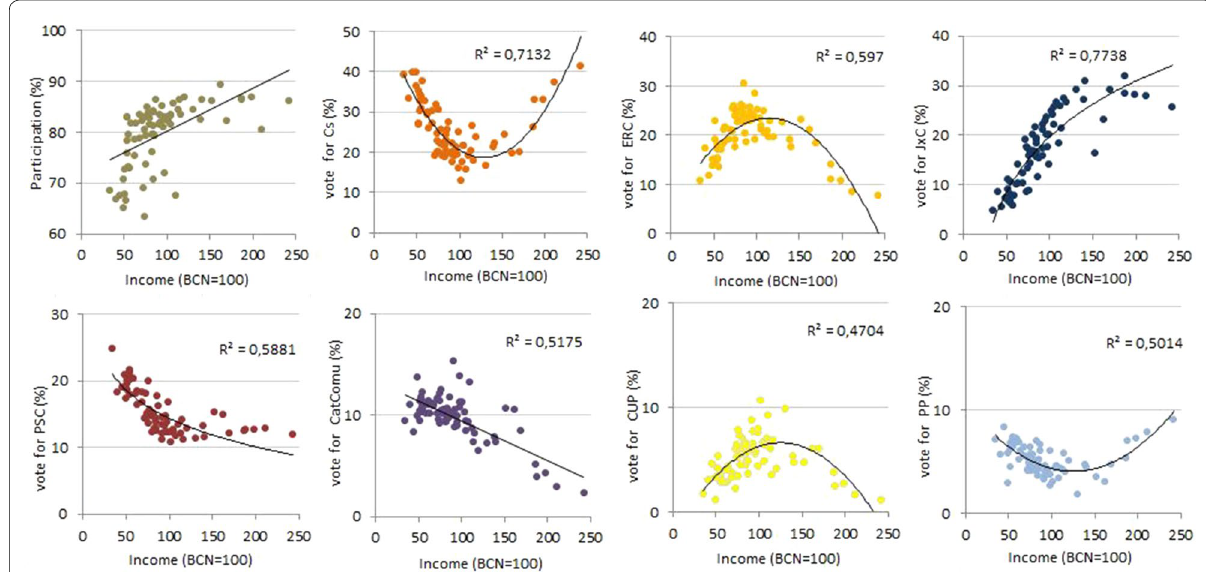
Fig. 7 Relationship between the percentage of the vote for the different parties (elections for the Parliament of Catalonia, December 2017) and income in the neighbourhoods of Barcelona (2016) [Source: own elaboration from the data provided by the Statistical Department of Barcelona’s City Council ( Ajuntament de Barcelona